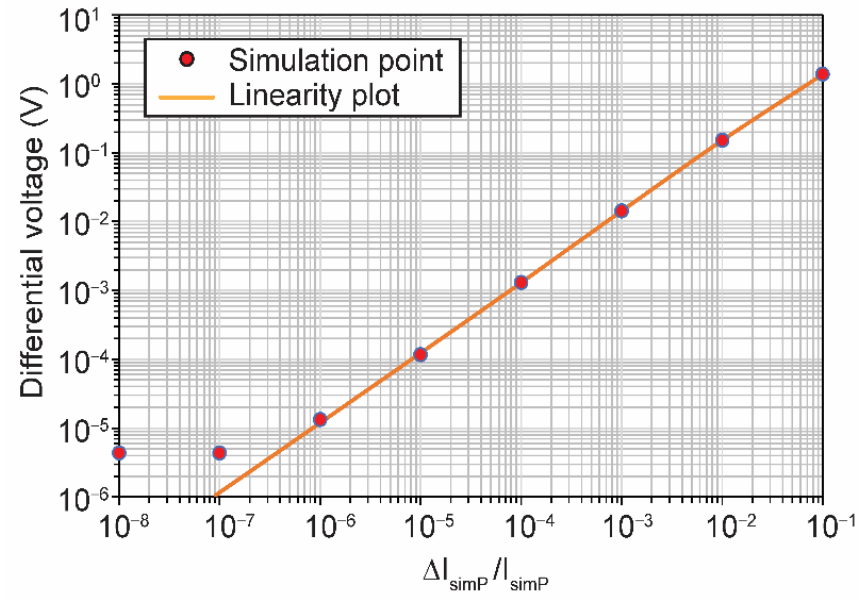
Figure 9. Simulated linearity plot for SRS signal detection.